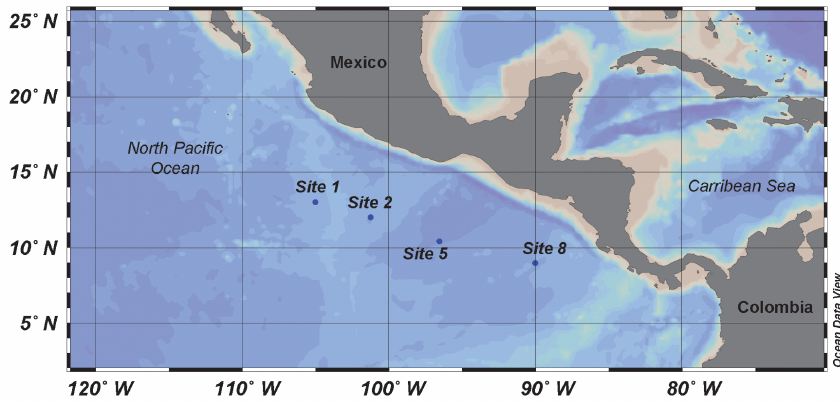
Figure 1. Map of ETNP with the R/V Seward Johnson (November 2007) cruise sampling stations investigated in this